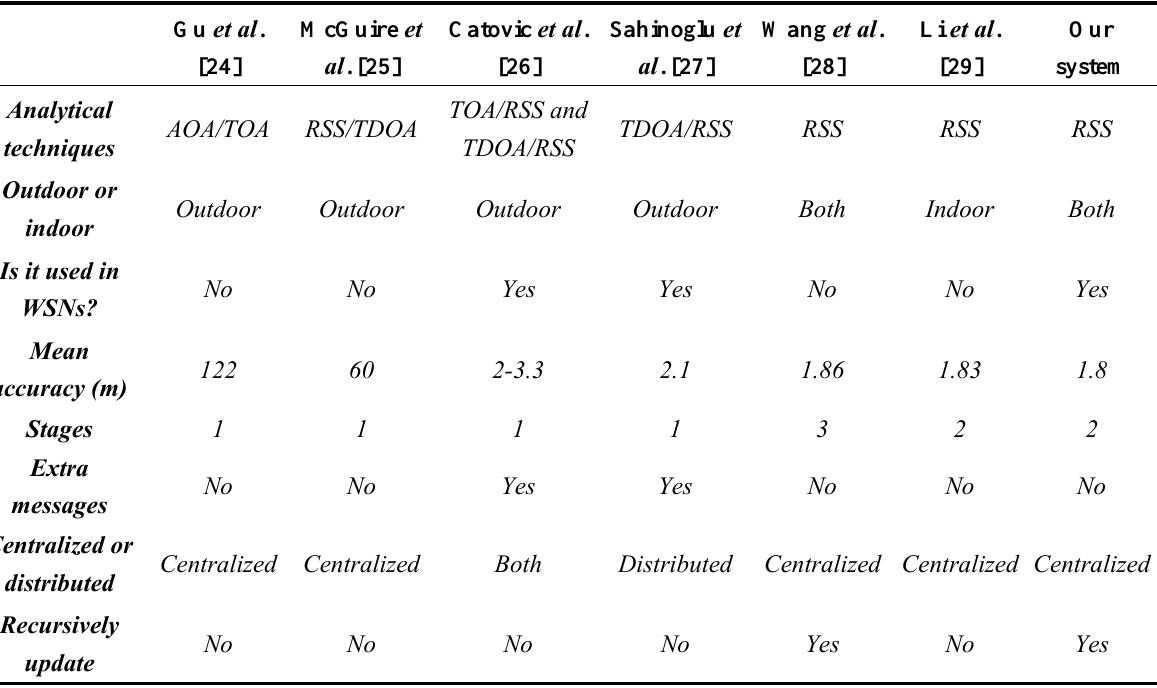
Table 3. Hybrid location systems